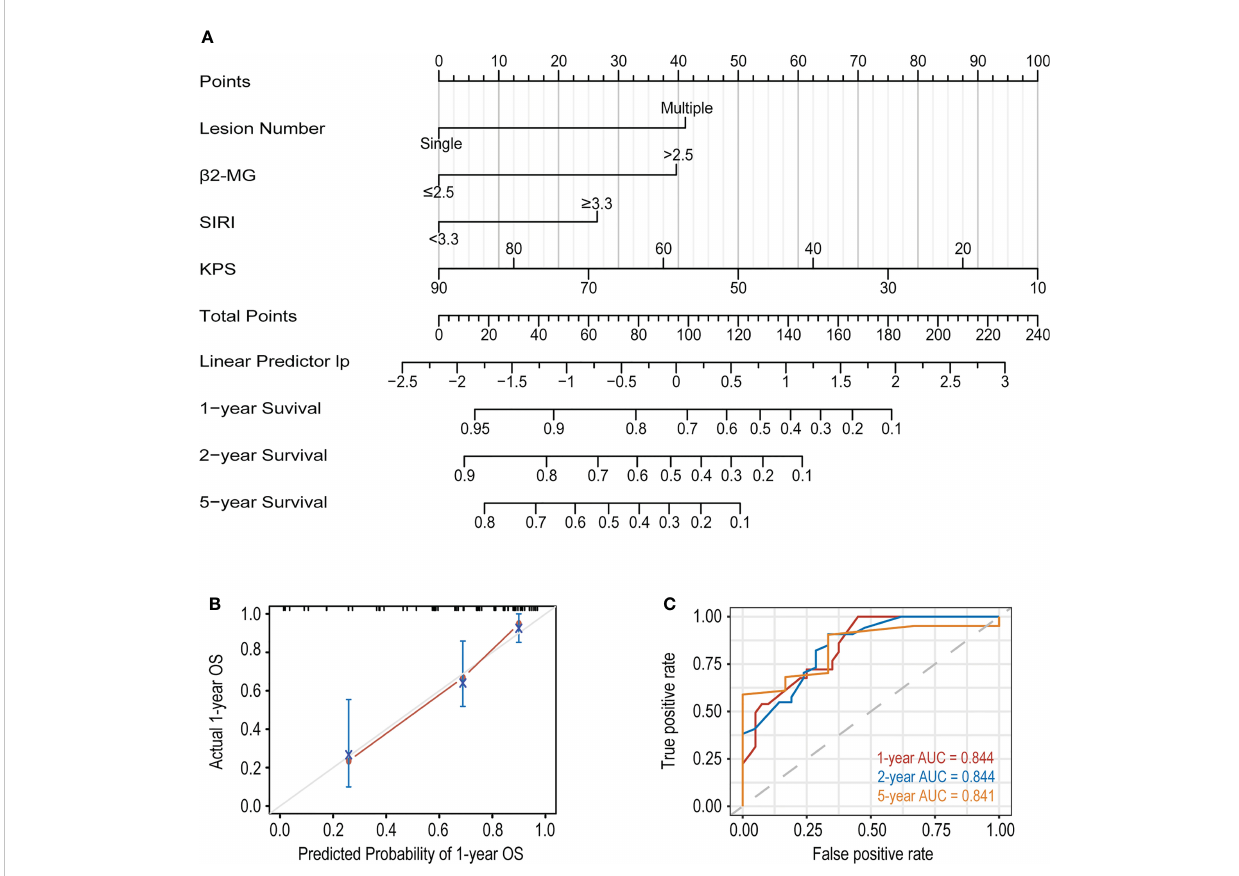
FIGURE 2 (A) The nomogram based on the development cohort to predict OS of PCNSL patients. (B) The calibration curve of the Xijing model for predicting 1- year OS. (C) The 1, 2 and 5-year ROC curves of the Xijing